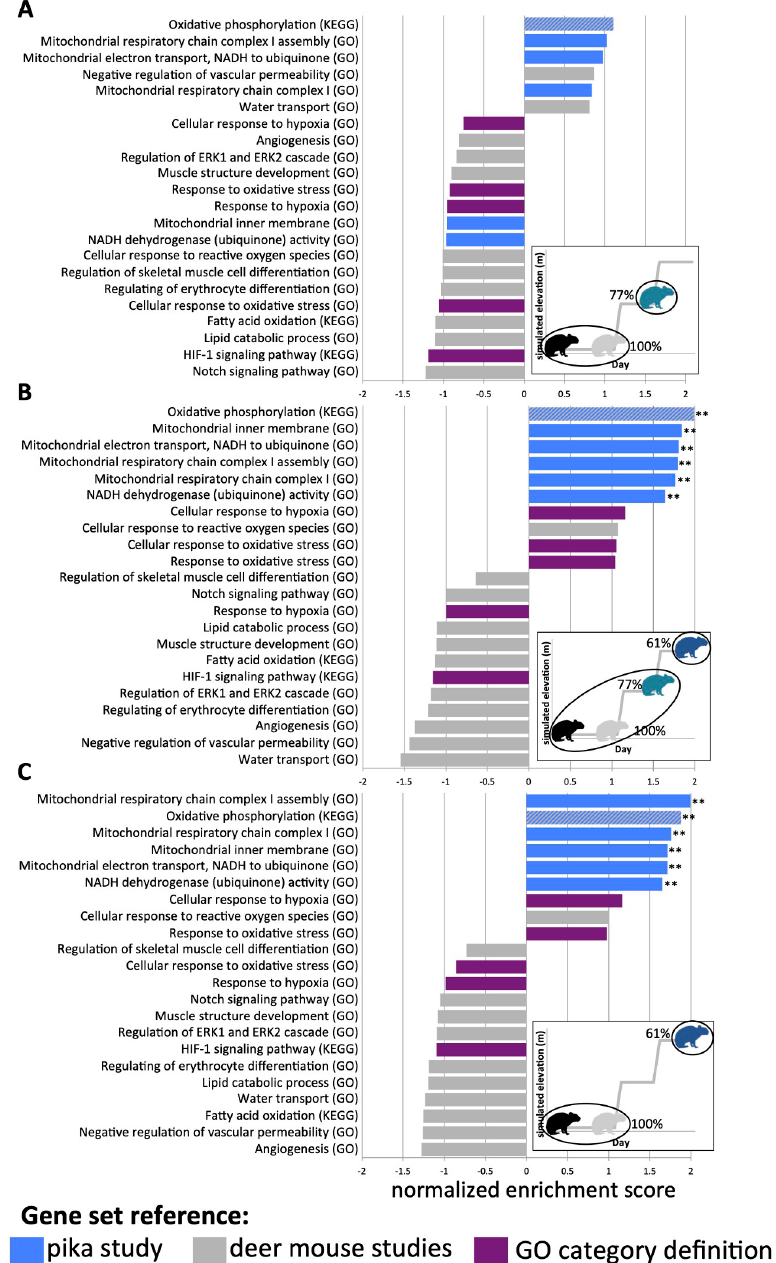
Fig 3. GSEA normalized enrichment score for each gene set. A diagram in the lower right of each panel indicates which sampling groups are being compared, with the percent oxygen compared to sea level of each sample group indicated. In all comparisons, the higher-elevation group is being compared to the lower-elevation group(s), so positive normalized enrichment scores indicate gene sets that are positively enriched in the higher-elevation samples compared to the lower-elevations samples. A) 2,000 m samples (77% oxygen compared to sea-level) compared to baseline and sea-level samples. B) 4,000 m samples (61% oxygen compared to sea-level) compared to all other samples. C) 4,000 m samples compared to baseline and sea-level samples. Gene sets drawn from the pika study are shown in blue, gene sets drawn from the deer mouse studies are shown in grey, and gene sets included due to their GO category definition are shown in purple. The oxidative phosphorylation pathway, which is drawn from both the pika and deer mouse studies is shown in blue and grey stripes. FDR q-values are indicated ( �� p < 0.01, � p < 0.05).